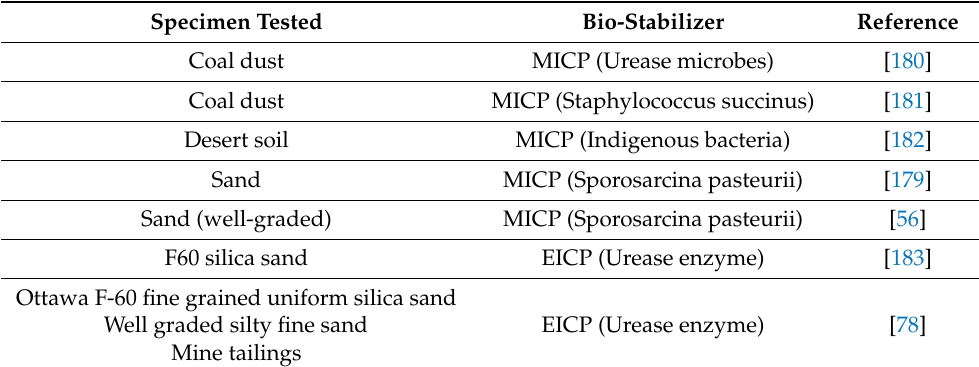
Table 3. Bio-stabilizers adopted for dust control in different non-plastic